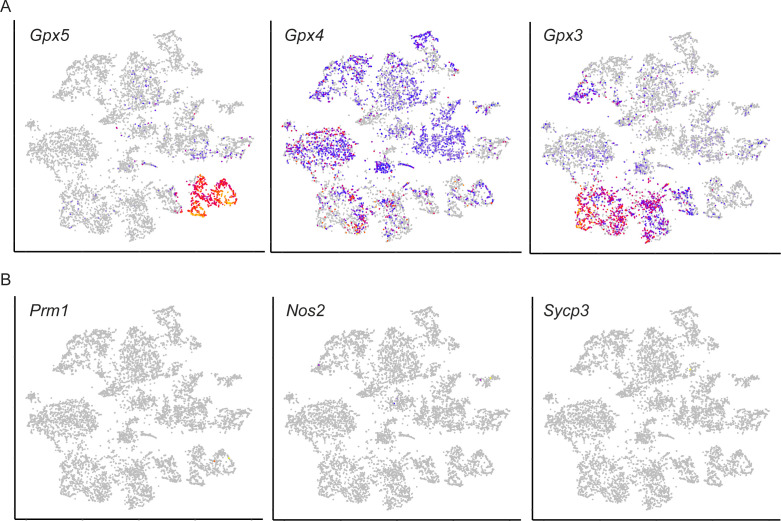
Additional images of gene expression levels across the entire single-cell dataset.(A) Gpx genes, including classic markers of caput (Gpx5) and cauda (Gpx3) principal cells, shown as in Figure 2C. (B) Several well-known sperm mRNAs, shown as in (A). We find no evidence for any sperm being captured, consistent both with our efforts to remove as many sperm as possible, and with the expectation that the unusually elongated dimensions of sperm would be incompatible with the droplet sizes used in the 10X Chromium platform.